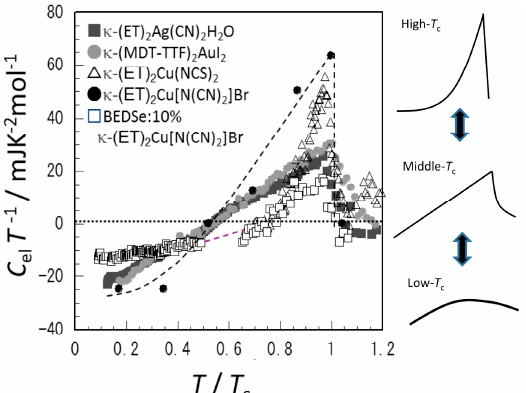
Figure 8. Shape of the thermal anomalies at the superconductive transitions of several compounds with the κ -D 2 X composition. ET is an abbreviation of BEDT-TTF molecules. BEDSe-TTF10% means that a solid solution system of BEDT-TTF(90%) and BEDSe-TTF(10%) molecules. C el in this plot is determined as the difference of the 0 T data and the heat capacity data obtained under magnetic fields higher than H c2 for each compound. (The data are from Ref. [33].) The dashed curves in the figure are a guide for the eyes to see temperature dependencies. The temperature in the horizontal axis is scaled by the transition temperature of each compound to compare the peak shape changes. The right part of the figure shows qualitatively the variation in the peak shapes in the dimer-Mott phase diagram.